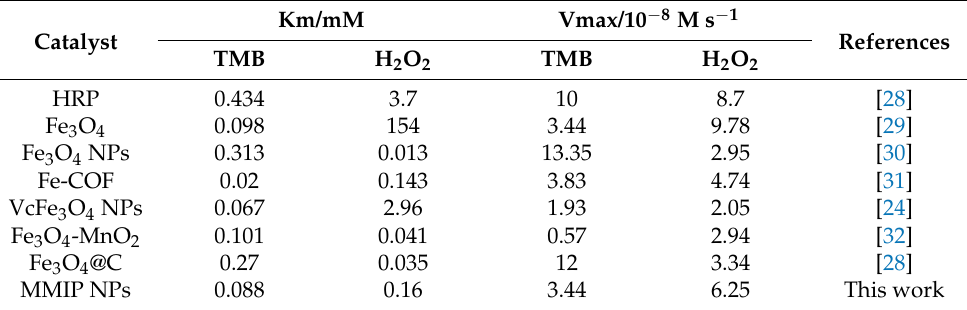
Table 1. Km and Vmax of HRP and